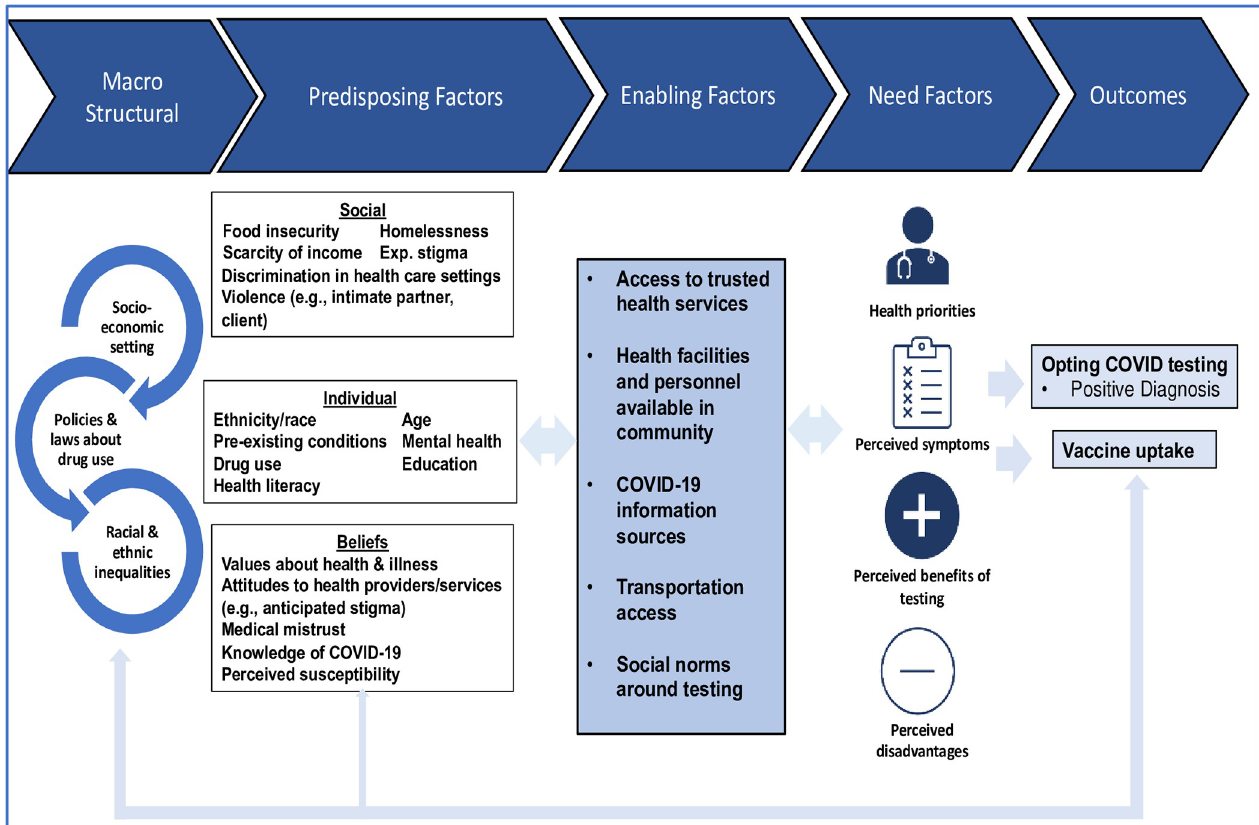
Fig 1. The CARE study conceptual